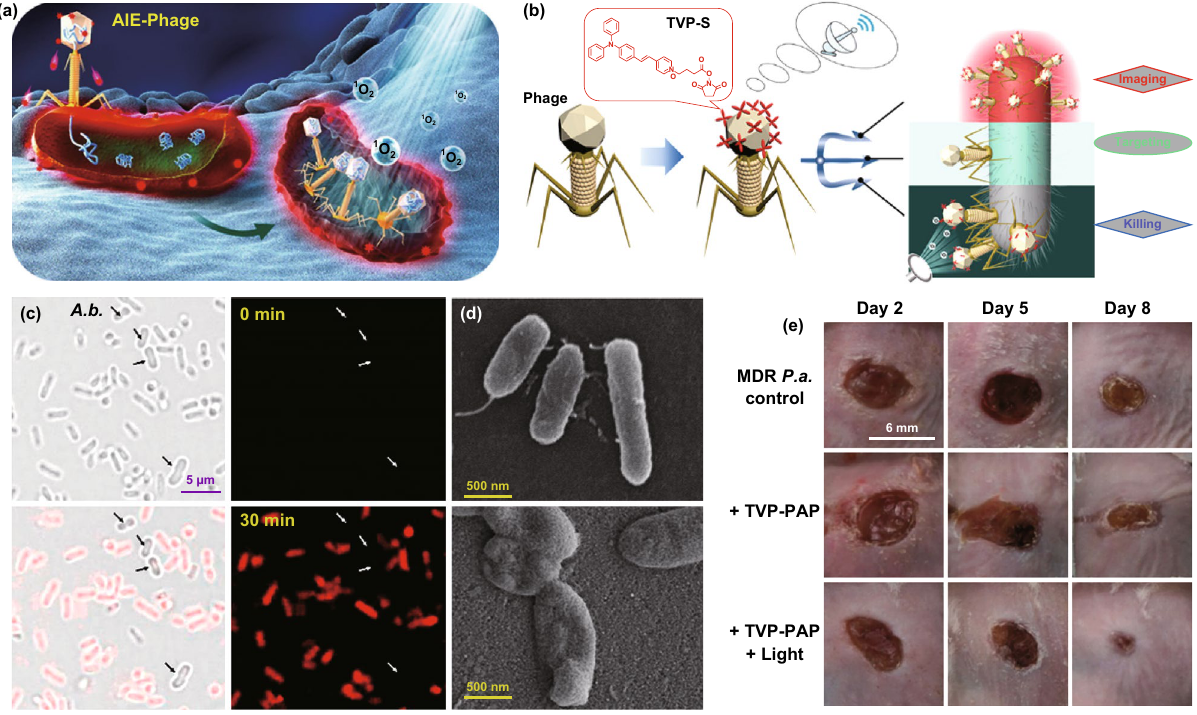
Fig. 6 a Cartoon illumination of bacterial imaging by AIE fluorescence and the phage infections as well as the ROS generation of phage-mod- ified AIEgens. b Synergistic effect of phage-modified AIEgens for bacteria-specific recognition, real-time fluorescent tracking, phage infection, and AIE-mediated aPDT. c Specificity evaluation of phage-modified AIEgens by fluorescence imaging of Pseudomonas aeruginosa (P.a.) and Acinetobacter baumannii (A.b.) indicated by arrows. d SEM imaging of bacteria before and after aPDT. e Photographs of wounds treated by phage-modified AIEgens and light irradiation for different time periods [78]. Copyright 2020 American Chemical